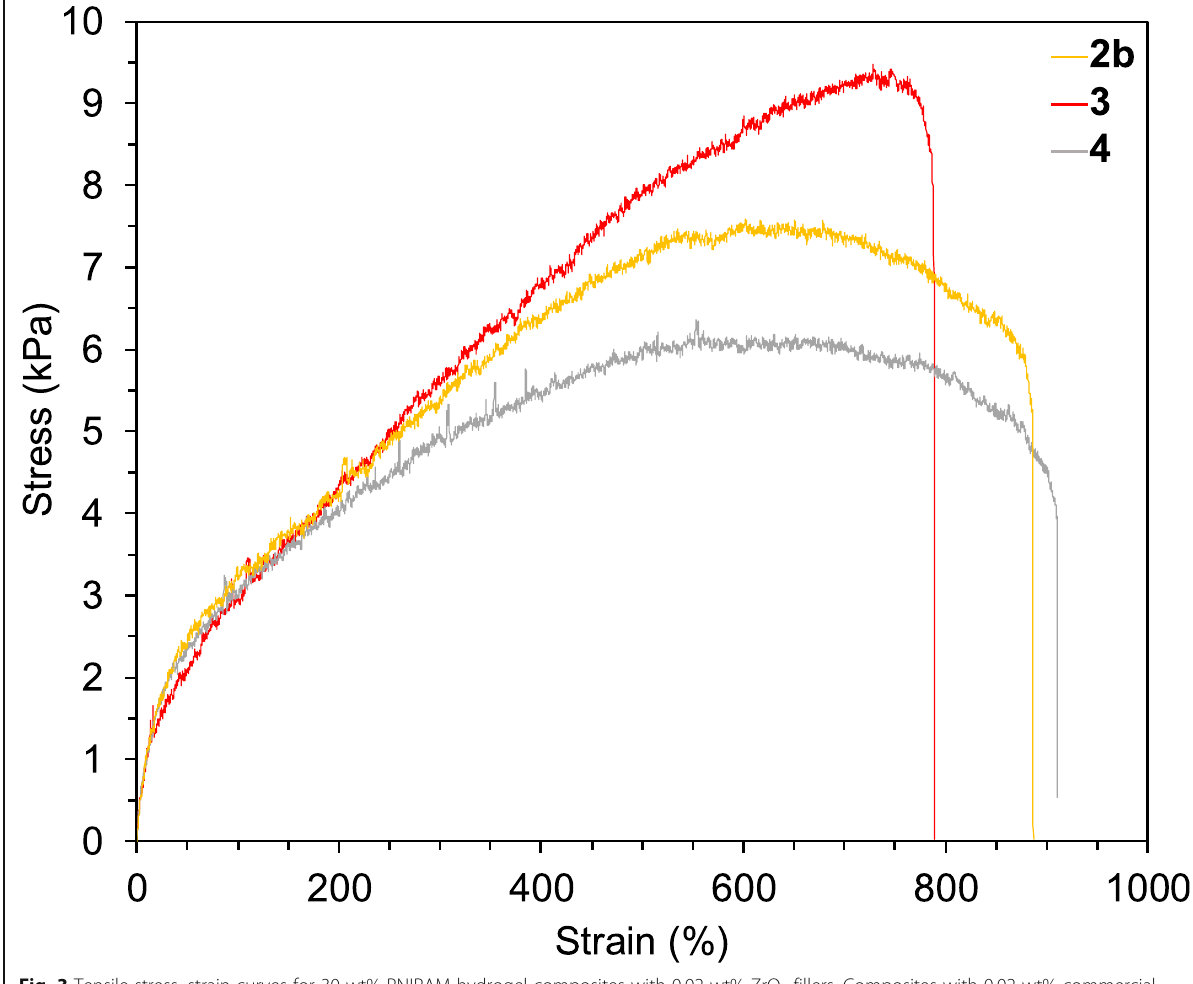
Fig. 3 Tensile stress – strain curves for 30 wt% PNIPAM hydrogel composites with 0.02 wt% ZrO 2 fillers. Composites with 0.02 wt% commercial ZrO 2 (2b), with 0.02 wt% nano-concave-convex surface ZrO 2 MARIMO (3), and with 0.02 wt% sintered ZrO 2 MARIMO